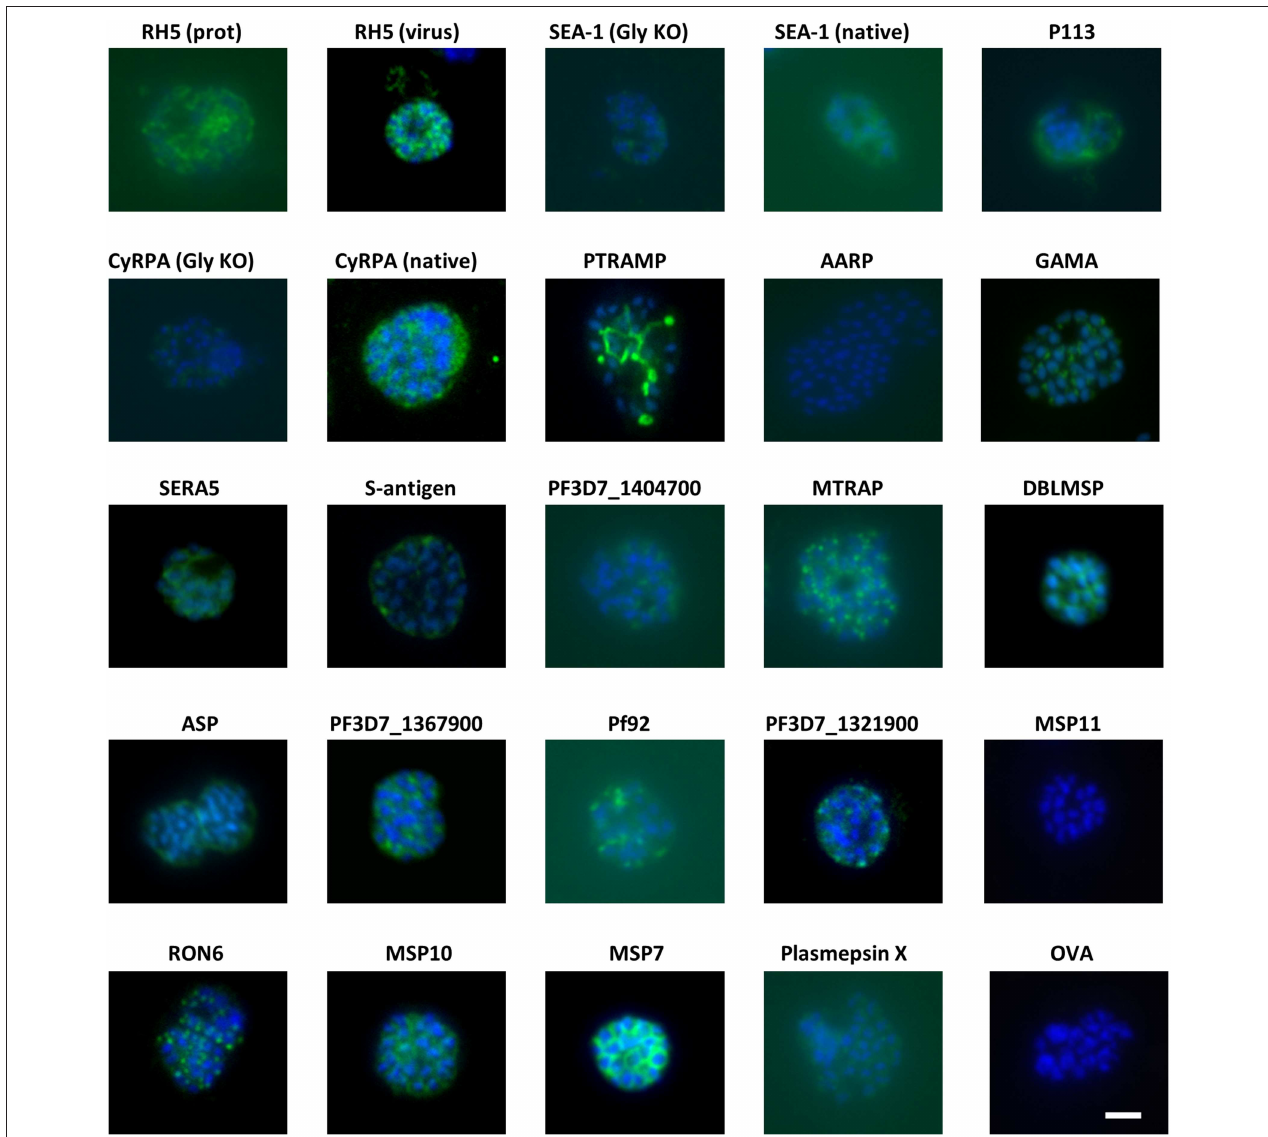
FIGURE 2 | Eighteen of twenty antigens elicit antibodies that react with P. falciparum schizonts. Groups of 4 mice were immunized with the proteins in adjuvants as shown in Figure 1 . Seven days after the final injection, serum was harvested and pooled for each group before purification of IgG using protein G. The IgG was then probed for reactivity to paraformaldehyde-fixed schizonts in an immunofluorescence assay at a total IgG concentration of 20 µ g/mL. All images were captured using the same microscope settings on the same day. Scale bar = 5 µ